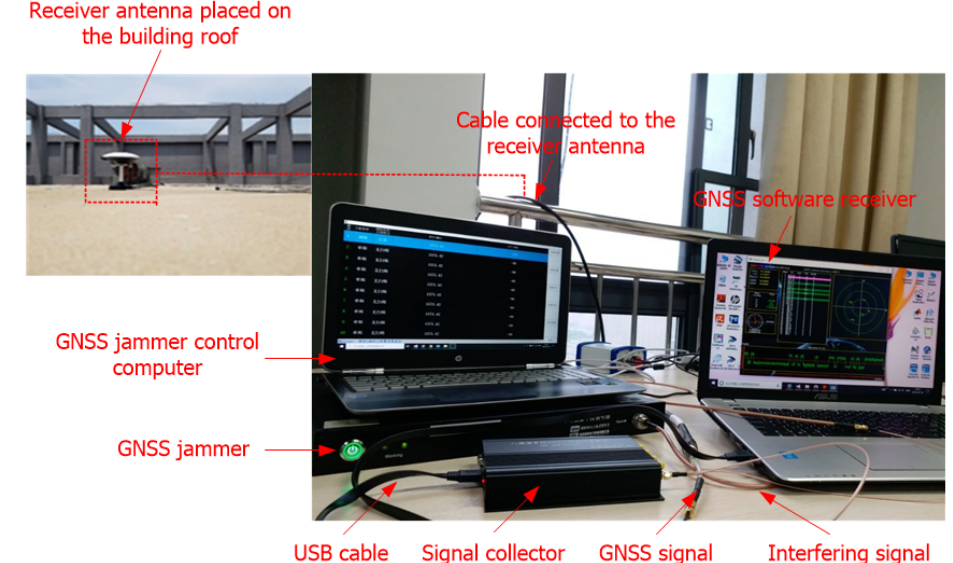
Figure 7. The scheme of the GNSS interference detection experiment.